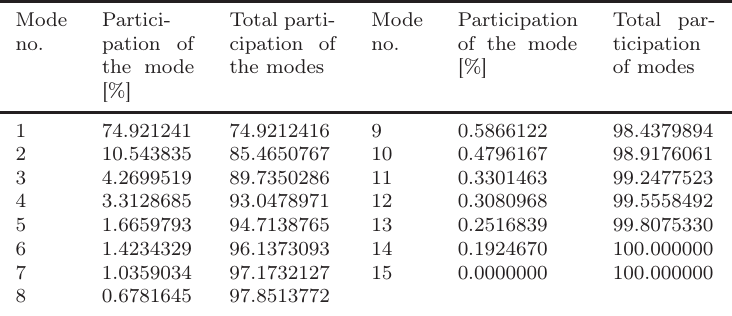
Table 1. Participation of the modes in decomposition. Mode